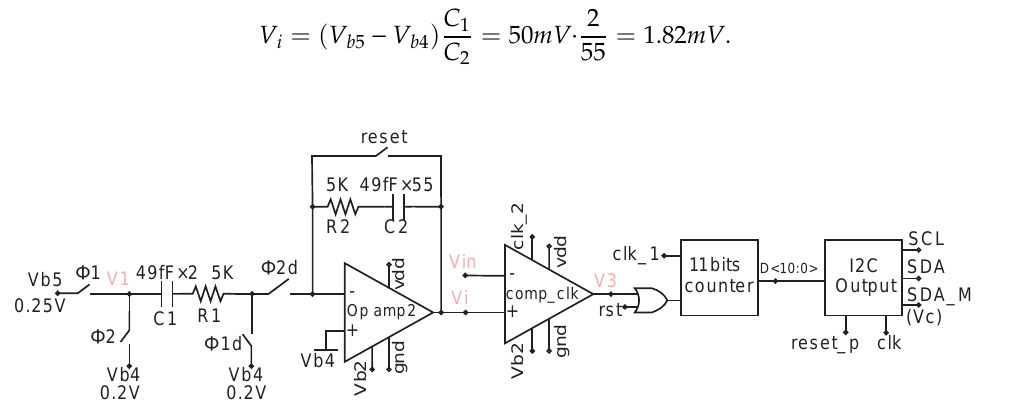
Figure 12. Single slope ADC with I2C output. The analog to digital converter (ADC) uses a switched capacitor integrator and clocked comparator. The integrator voltage per step (clock Φ2) is 1.3 mV. However, the post layout simulated result for Vi is 1.3 mV due to the coupling parasitic capacitance of C2, which is estimated to be 1.07 pF. The schematic of the clocked comparator is shown in Figure 13.